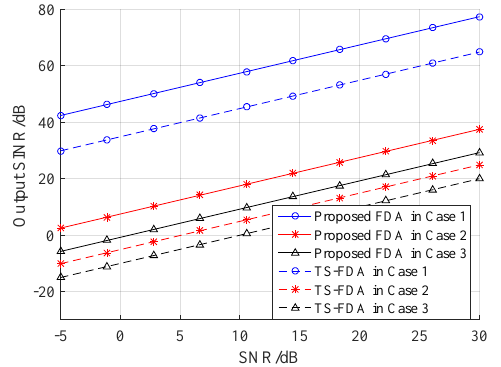
Figure 5. Output SINR vertus SNR in different interference cases.